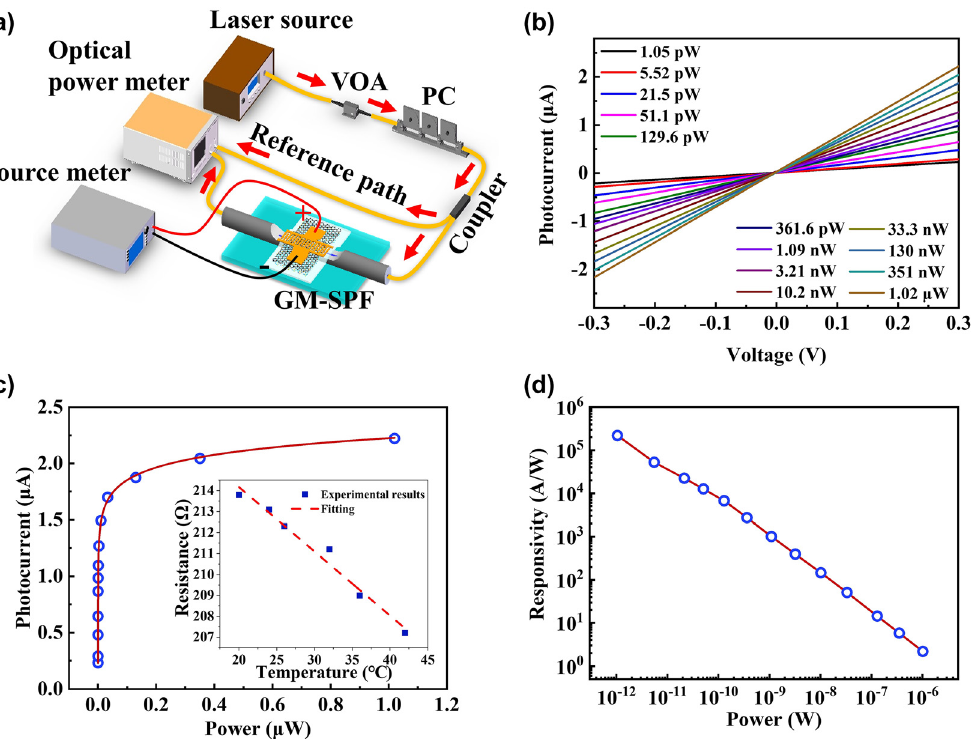
Figure 4: The photodetection characteristics of PPID. (a)Experimentalsetupofphotodetection;(b)relationshipbetweenphotocurrentandappliedvoltageofthedevicefordifferentlightpowersat a wavelength of 1550 nm; (c) relationship between photocurrent and light power under 0.3 V bias, the inset is the resistance of PPID changing with the rising temperature under 0.3 V; (d) relationship between responsivity and light power under 0.3 V